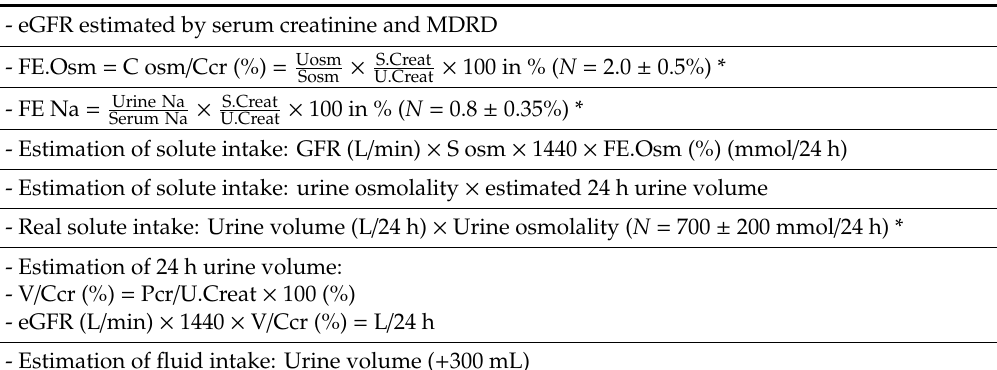
Table 1. Formula used to estimated daily solute intake, urine volume and water intake. - eGFR estimated by serum creatinine and